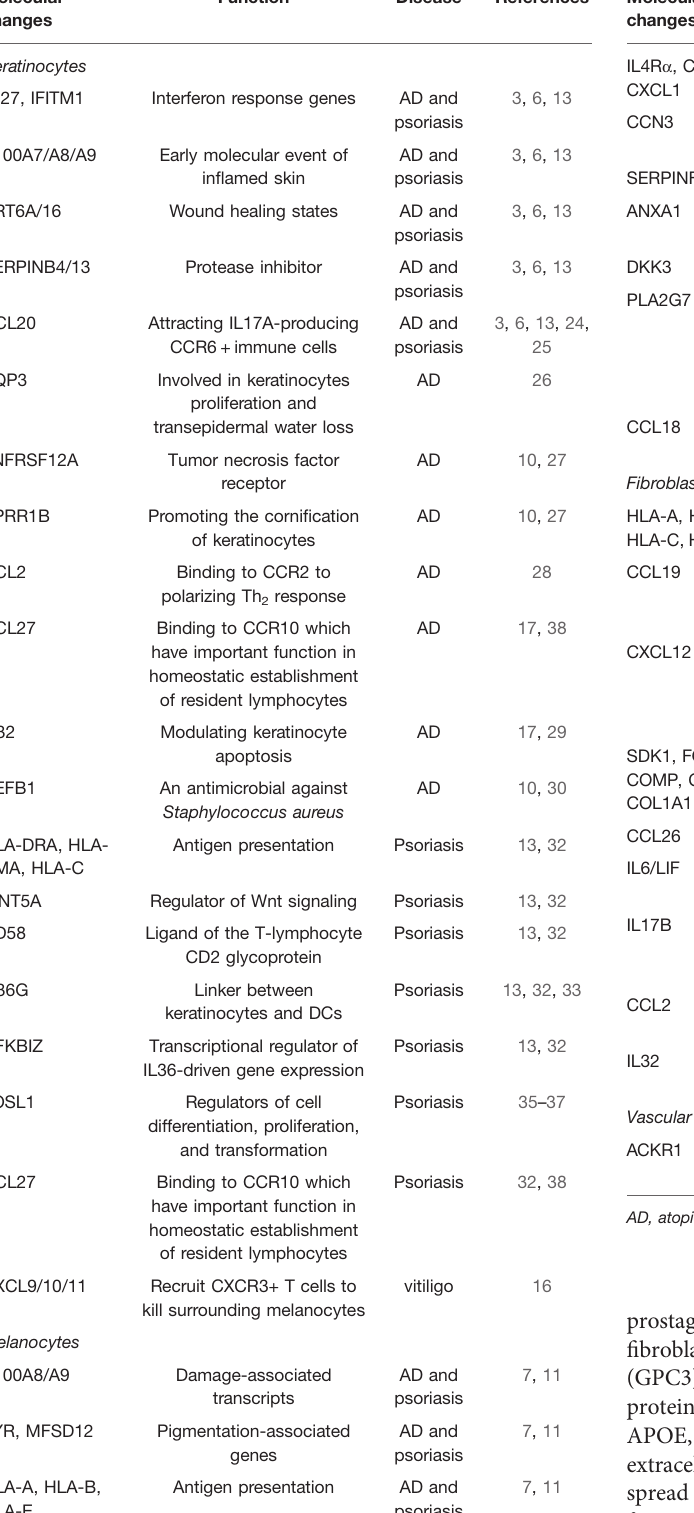
extracellular matrix protein 1 (EFEMP1)] that are widely spread within the dermis (22). Another study re-analyzed the four published datasets and classi fi ed fi broblasts into three major subsets: type A accounted for about 49.5% of the